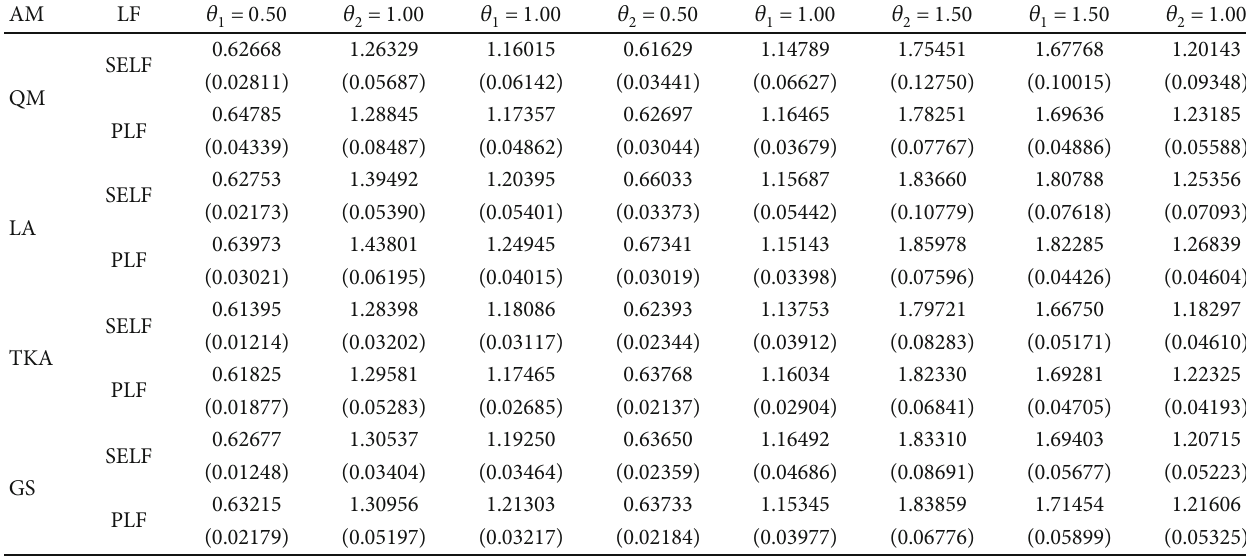
Table 6: BEs and PRs (in parentheses) under IP for n = 30 .